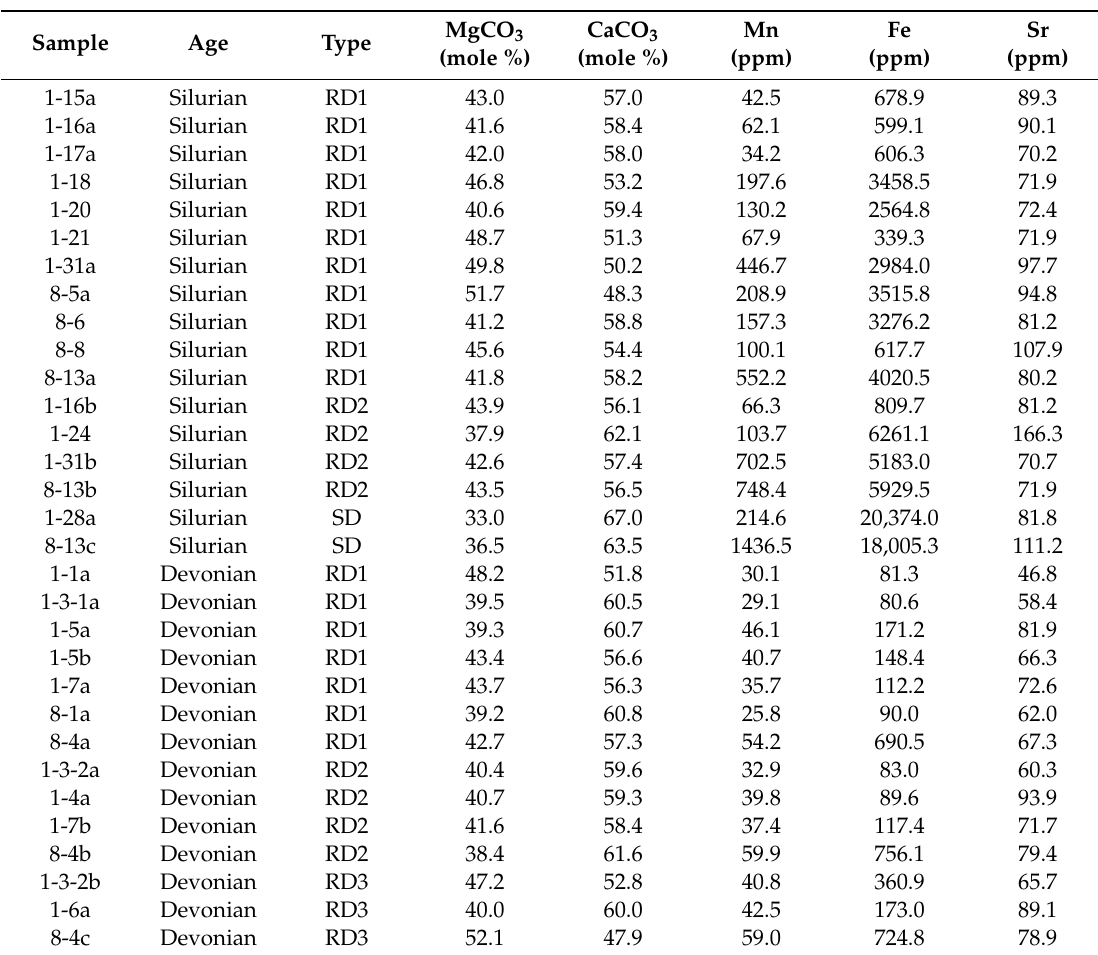
Table 5. Major, minor and trace elements